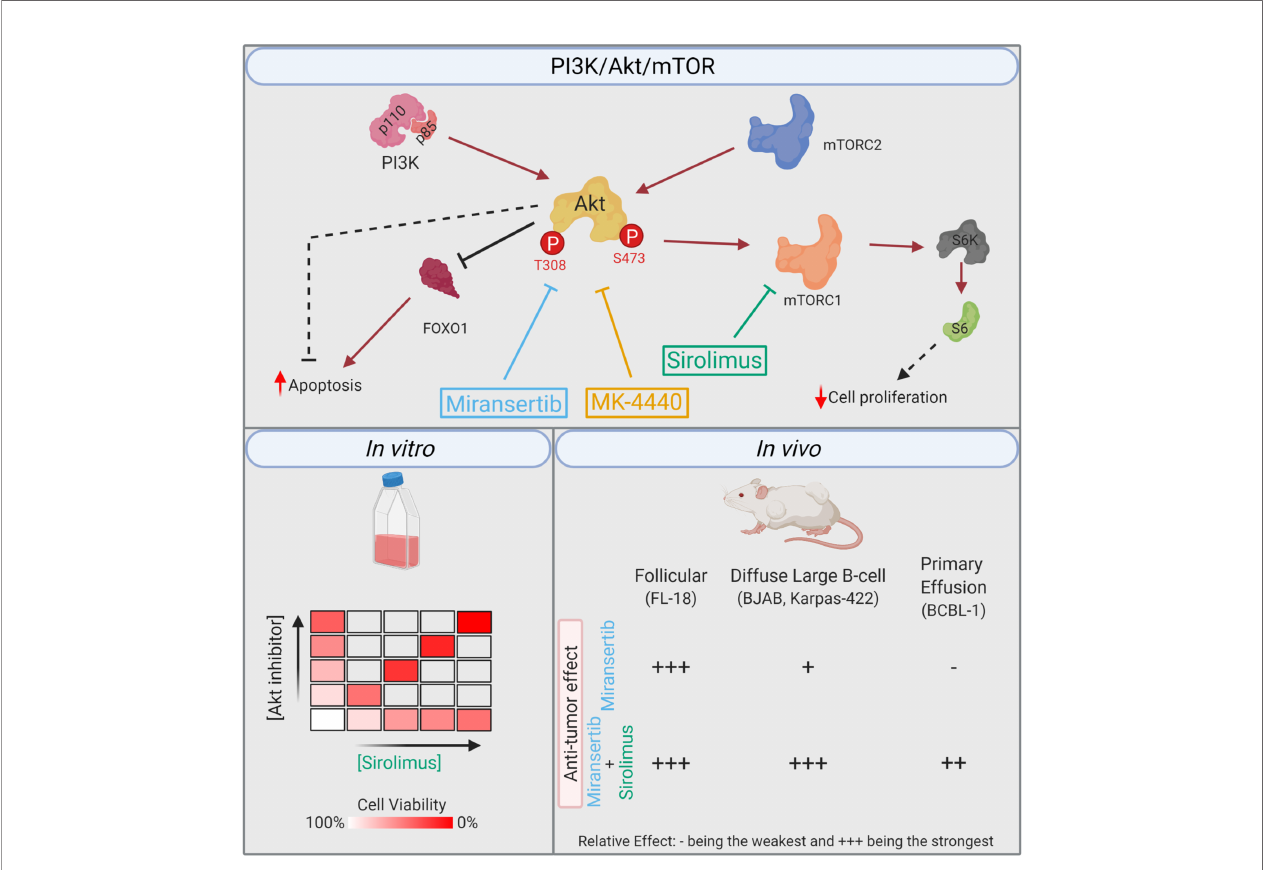
FIGURE 9 | Summary. Simpli fi ed model of the PI3K/Akt/mTOR pathway, including the compounds and their respective target. The in vitro studies demonstrated that the combination of miransertib or MK-4440 and sirolimus was synergistic against a variety of NHL cell lines. In the in vivo studies, the follicular lymphoma model was highly sensitive to miransertib treatment alone. The diffuse large B-cell lymphoma models were slightly sensitive to miransertib, but the addition of sirolimus strongly repressed tumor growth. For the highly aggressive primary effusion lymphoma model, only mice treated with the combination of Akt and mTOR inhibitors suppressed tumor growth (created with